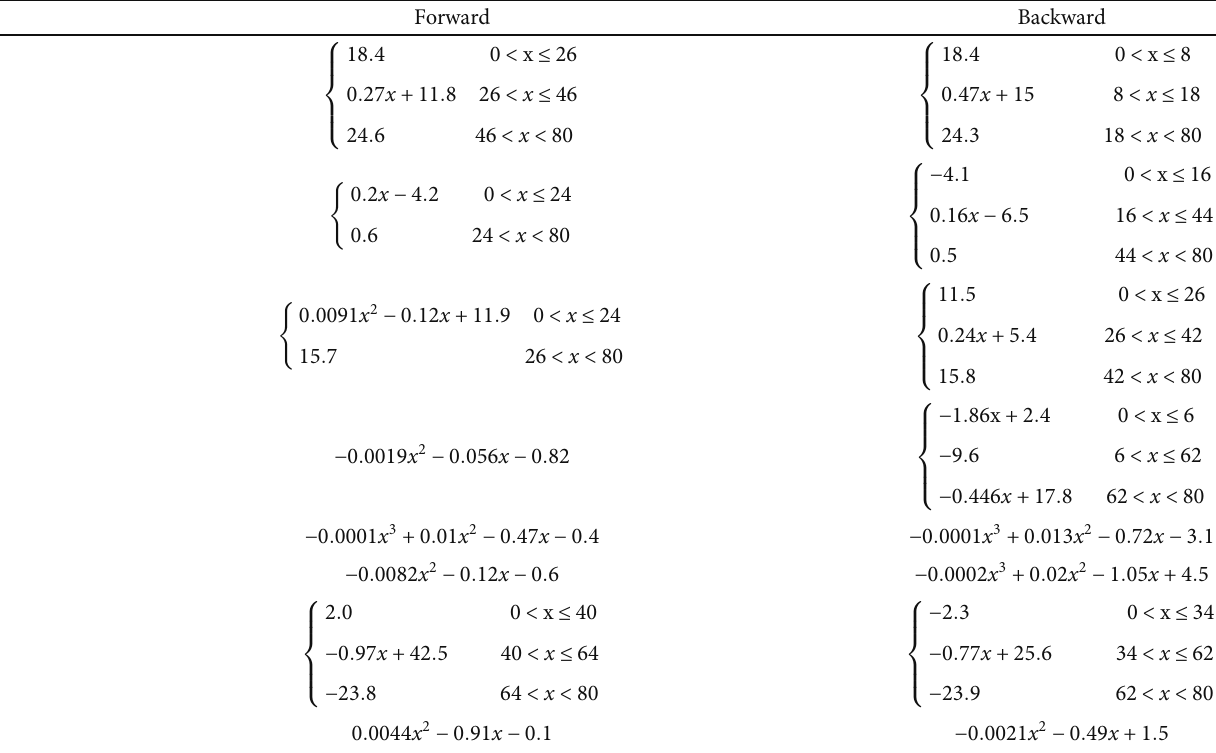
Table 3: Expression of fi tted joint